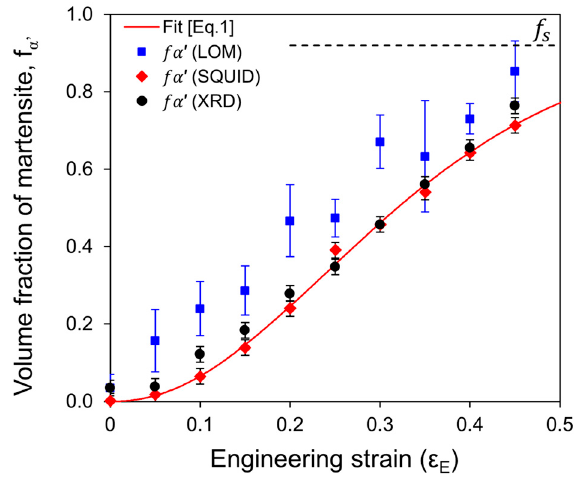
Figure 5. Evolution of martensite volume fraction ( f α (cid:48) ) with strain ( ε E ) obtained ex-situ from interrupted tensile tests determined by LOM, magnetization measurements (SQUID), and XRD. The dashed line represents the saturation value of transformed martensite ( f s = 0.92) found by XRD for sample strained to fracture.